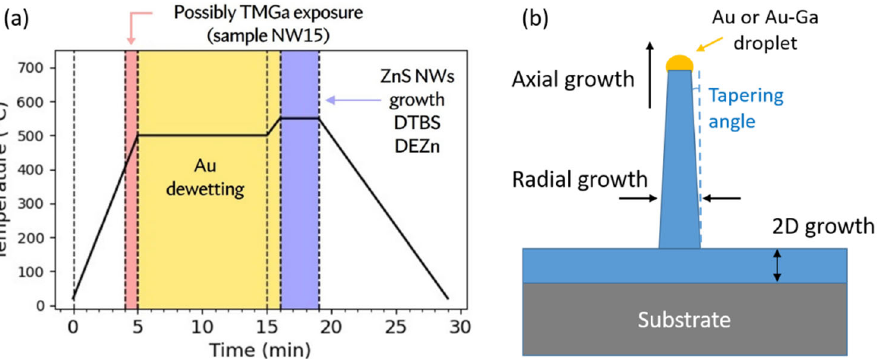
Figure 4. ( a ) Typical growth diagram, note that the TMGa flux is only applied for sample NW15, and ( b ) Schematic of NW growth, distinguishing axial, radial and 2D growths.